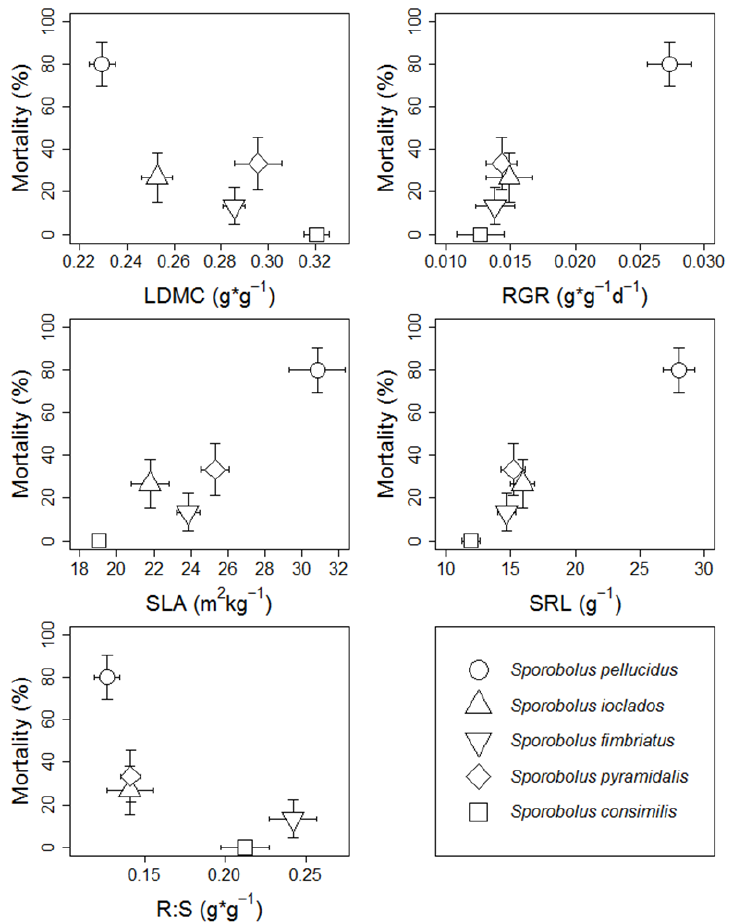
Figure 3. Mortality (± SD of Bernoulli distribution) plotted against the mean (± SE) trait values of five Sporobolus species. LDMC = leaf dry matter content; RGR = relative growth rate; SLA = specific leaf area; SRL = specific root length; and R:S = root to shoot dry mass ratio. Shapes represent different species found in the legend.